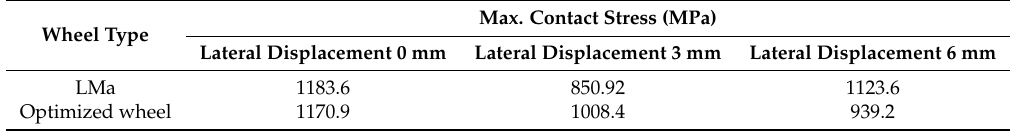
Table 1. Maximum wheel-rail contact stress.